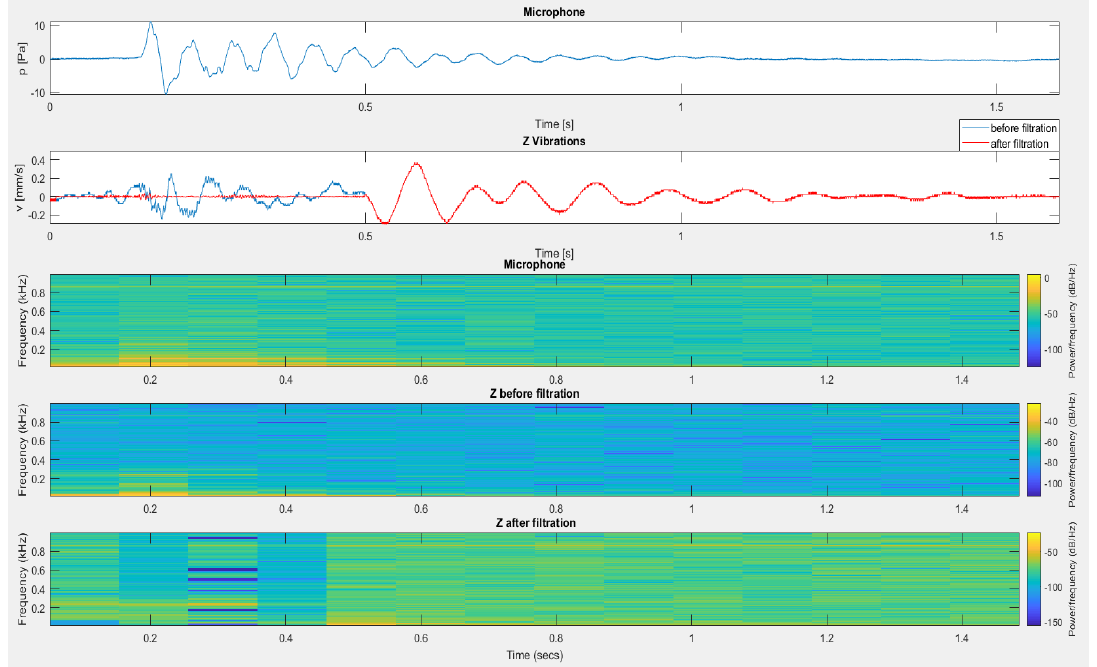
Figure 20. The result of using filtration for the vertical component from a sensor placed inside the building—detonation of dynamite material placed in a short blast hole.